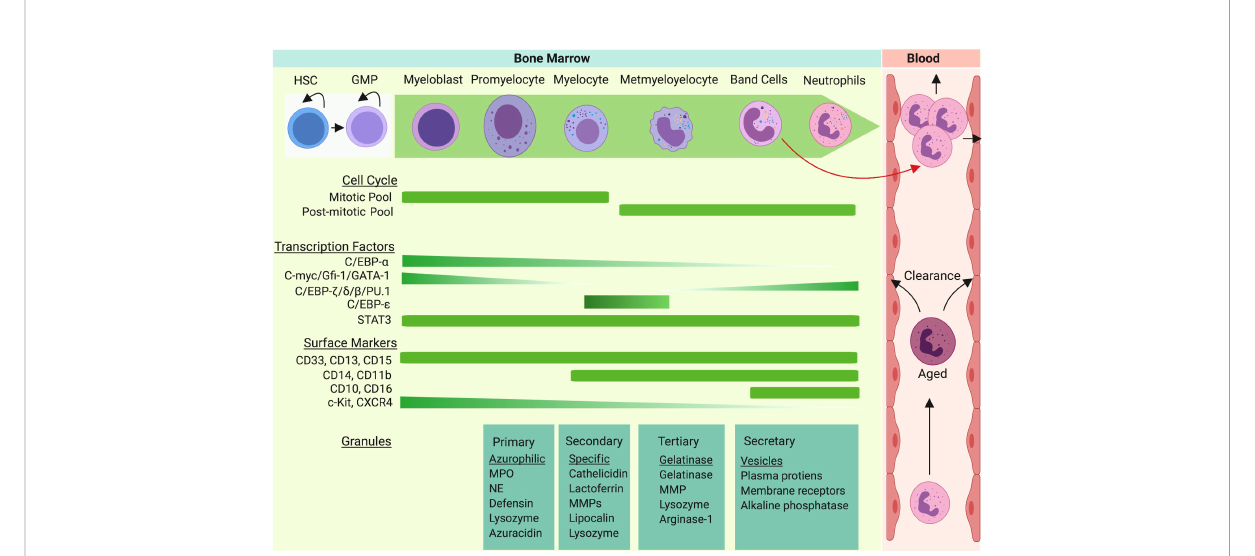
FIGURE 1 Neutrophil granulopoiesis is a hierarchical program of the hematopoietic system. Granulopoiesis, the process of neutrophil generation and maturation, is characterized by sequential development of distinct granules, surface proteins, and nuclear segmentation. Homeostatic granulopoiesis starts with generation of myeloblasts and promyelocytes (rich in primary azurophilic granules) which depends on expression of GATA-1, C/EBP- a , G fi -1, and c-Myc genes. The development of secondary speci fi c granules appears in myelocytes (last proliferative stage). C- Myc and C/EBP- ϵ contribute to formation of secondary granules. The development of metamyelocytes with gelatinase granules marks terminal differentiation of neutrophil granulopoiesis. As expression of C/EBP- b , C/EBP- d , and C/EBP- z are upregulated in terminal neutrophil stages, gelatinase granules and secretary vesicles appear and nuclear segmentation intensi fi es. During emergency granulopoiesis, C/EBP- b takes over the process and an excess amount of neutrophils are generated and released to the bloodstream along with immature neutrophils (band